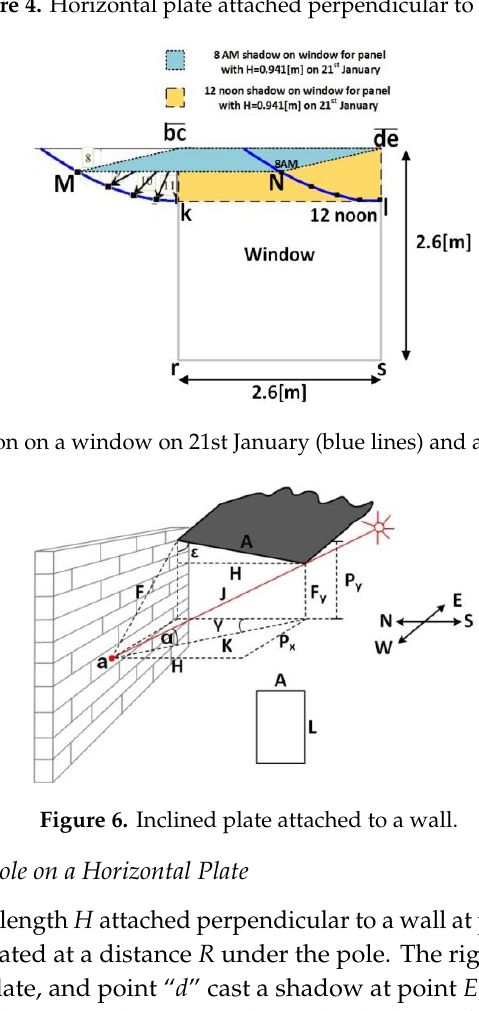
Figure 6. Inclined plate attached to a wall.